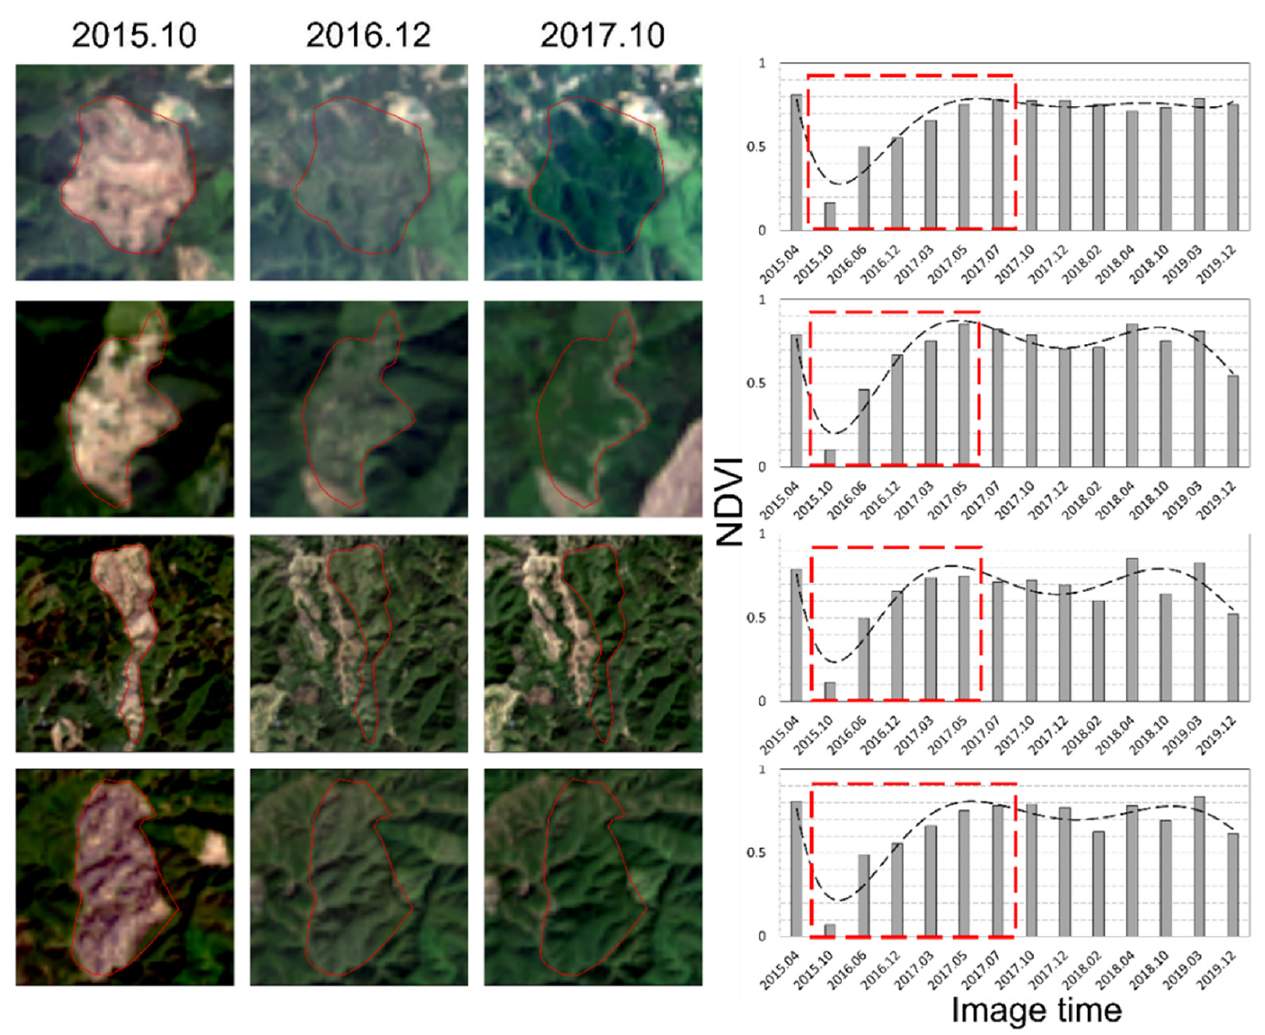
Figure 5. The images of four regions with different stages and time series average NDVI of selected regions from April 2015 to December 2019, the red dashed box is used to highlight the change in NDVI of eucalyptus over time, which gradually increases inside the red dashed box and stops changing outside the red dashed box.